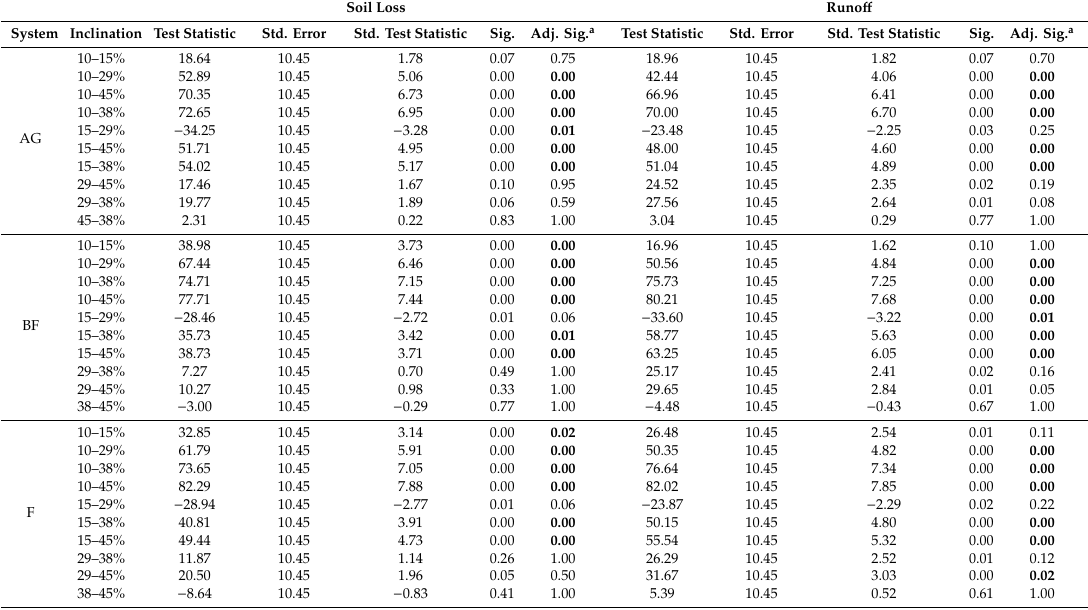
Table 5. Pairwise comparisons between slopes for soil loss and runo ff for three land uses (AG: agricultural land, BF: burnt forest, F: forest). SoilLoss Runo ff System Inclination TestStatistic Std.